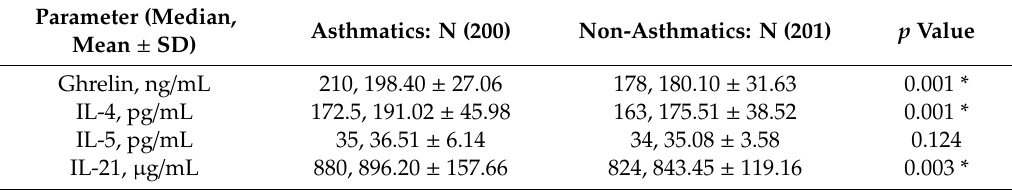
Table 2. Ghrelin and interleukin levels among the study sample with the presence of bronchial asthma. IL: interleukin.